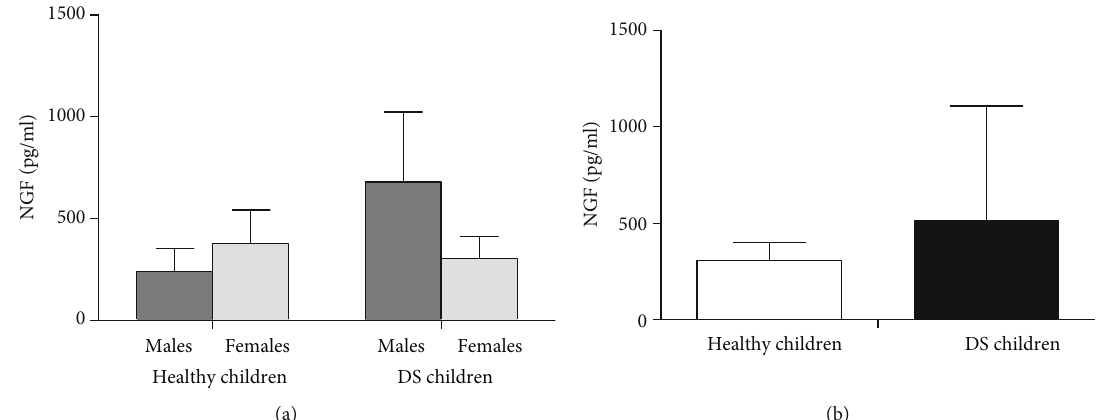
Figure 1: Nerve growth factor (NGF) levels in male and female DS prepubertal children and in the control group ((a) shows the data according to gender but (b) are without it). The error bars indicate pooled standard error means (SEM) derived from appropriate error mean square in the